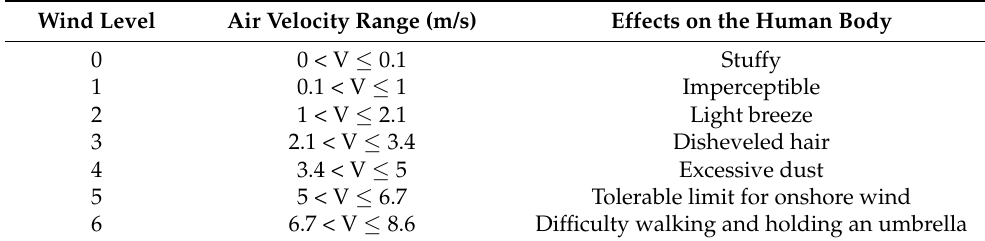
Table 2. Evaluation standard for the correlation between air velocity and comfort.